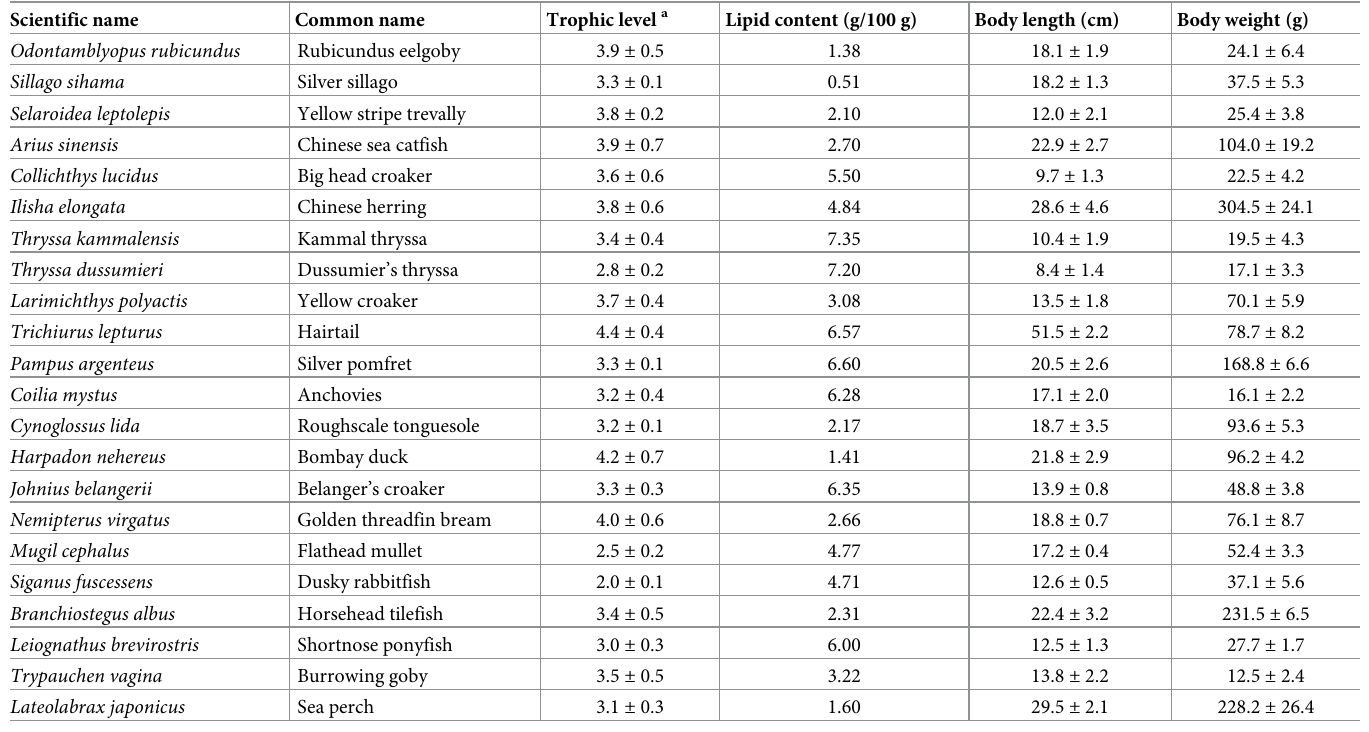
Table 1. Fish species (n = 10 for each species) examined in the present study and their lipid contents and trophic